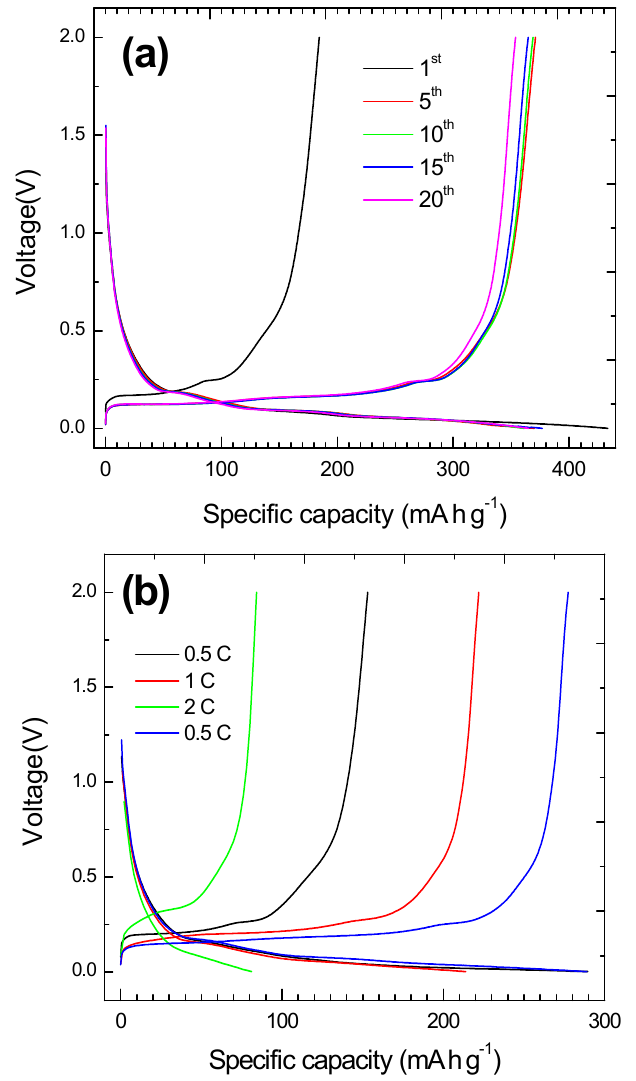
Figure 10. ( a ) Charge/discharge curves at 0.2 C of a Li-ion battery using recycled graphite CL 1 BM as anode material. ( b ) First charge/discharge curves at different current densities.